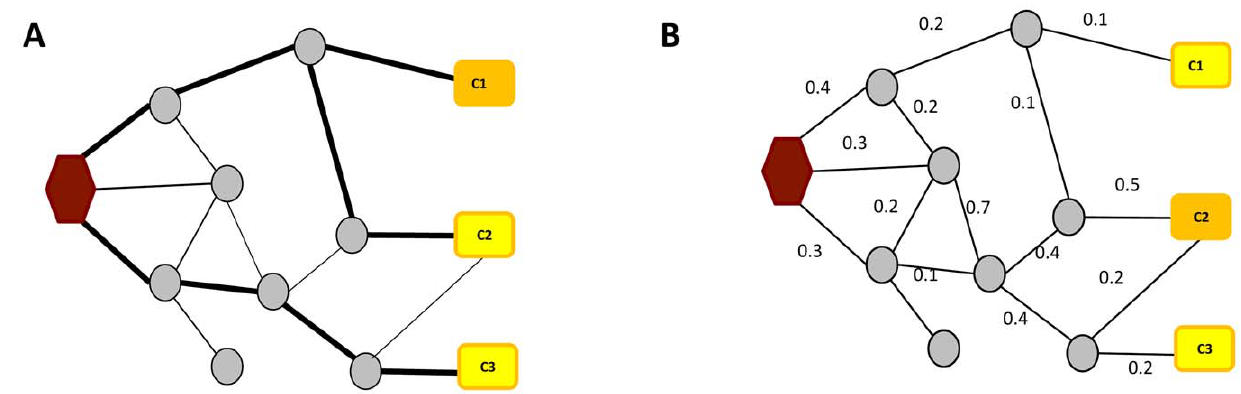
Figure 3. Finding information propagation modules. (A) Shortest path approach to uncover information propagation. The shortest paths from a target gene (with hexagon shape) to each of three candidate genes are shown. The closest gene is identified as the most probable disease causing gene. (B) Flow based approach. The gene receiving the most significant amount of flow is identified as the disease gene. The information flow methods often follow Kirchhoff’s current law (the amount of incoming information equals the amount of outgoing